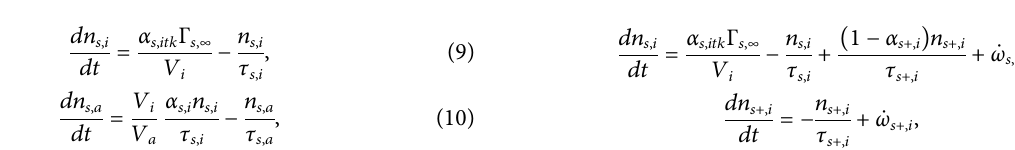
Frontiers in Physics |